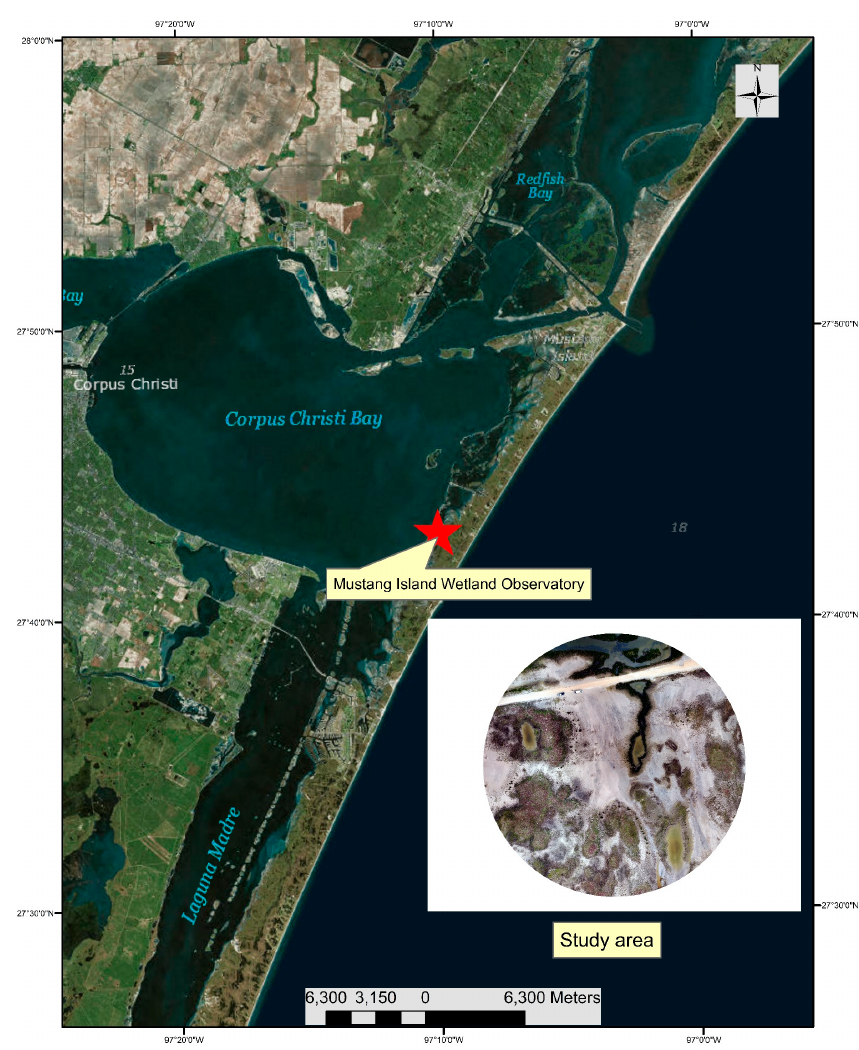
Figure 1. Study area at Mustang Island Wetland Observatory. The circular inlay is the study location imaged from an Unmanned Aircraft System (UAS).